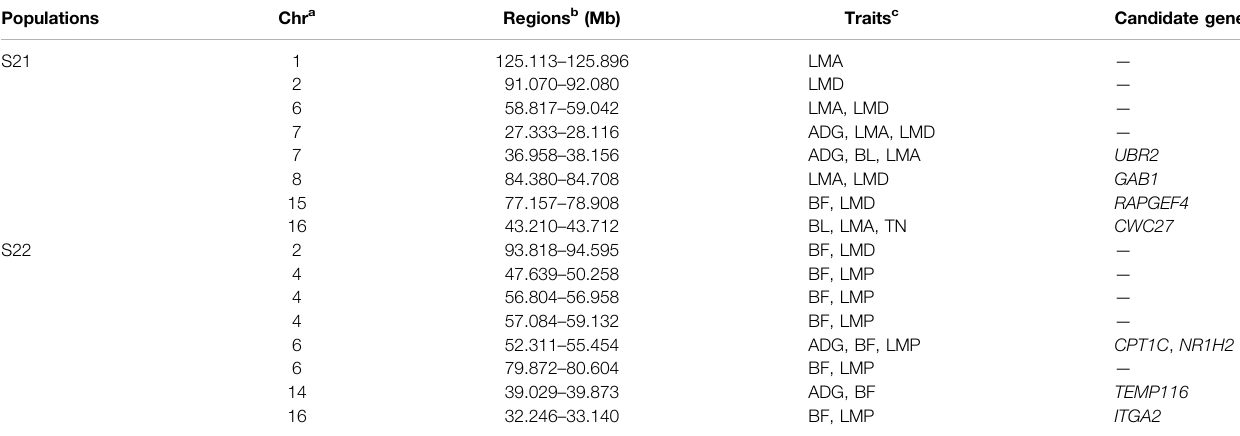
TABLE 2 | Phenotype-related ROHets overlapped with ROHet islands.